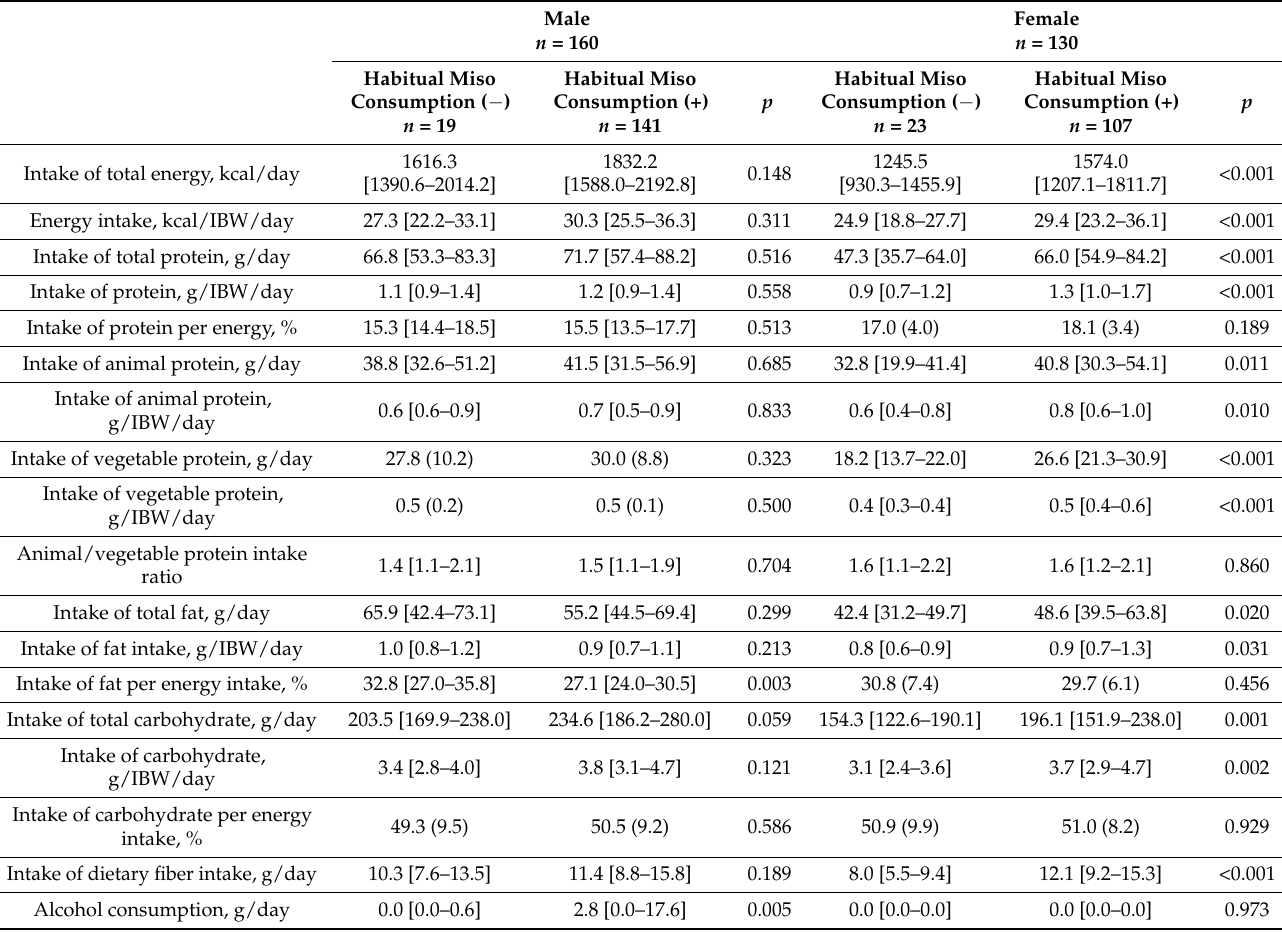
Table 4. Habitual diet intake according to habitual miso